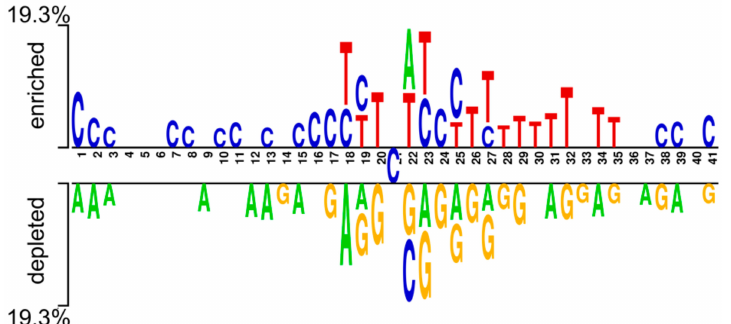
Figure 2. Compositional inclinations of sequences between 4mC and non-4mC sites. Logo mentioned above the axis indicates compositional preferences of positives, while the logo below the axis indicates compositional preferences of